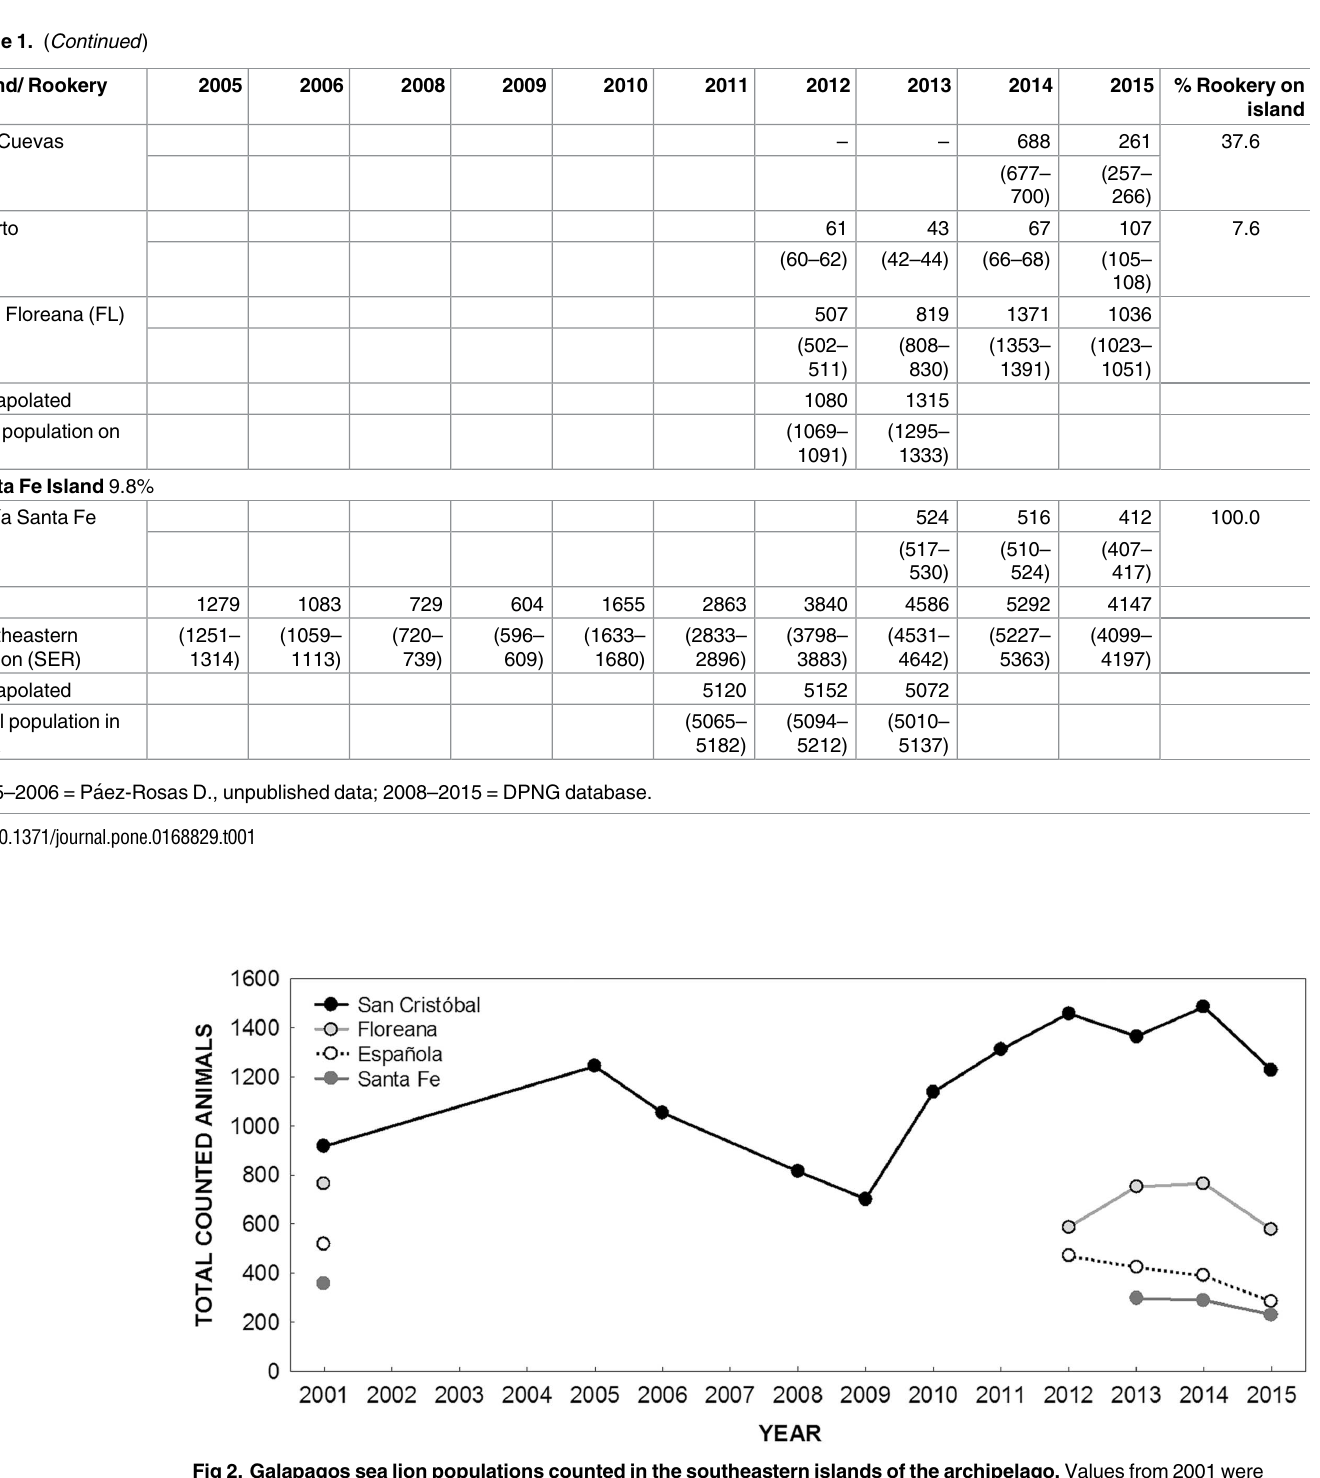
Fig 2. Galapagos sea lion populations counted in the southeastern islands of the archipelago. Values from 2001 were taken from [1]. Populations from 2005 to 2010 on San Cristo ´ bal, in 2012 on Espa ñ ola,and in 2012–2013on Floreanawere extrapolatedbasedon the percentage ( (cid:21) 46%) of the populationcensusedin each year per island. In all other cases, all the rookeriesof the islands were sampled.For percentages of the population censusedin each rookery, see Table